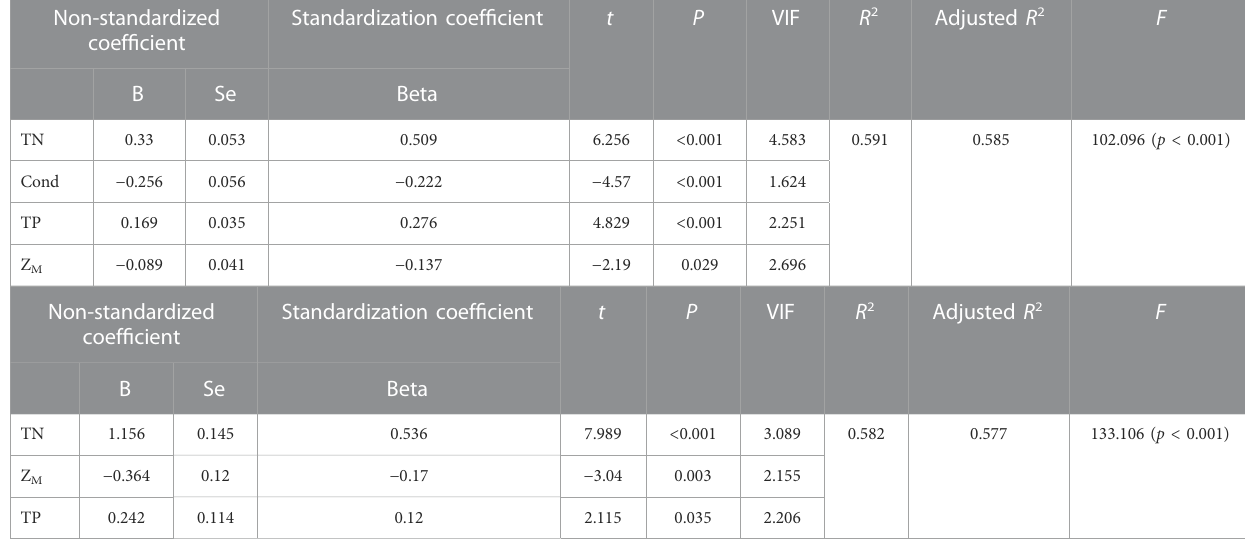
TABLE 2 Multiple stepwise regression analysis of zooplankton species number, biomass and environmental parameters.